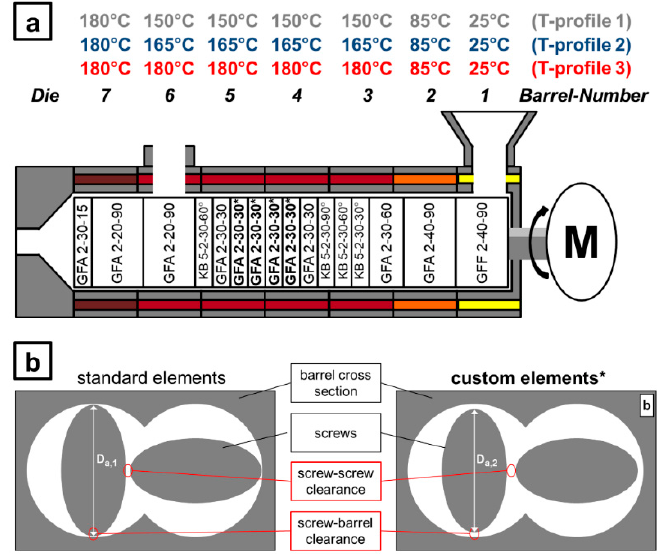
Figure 1. ( a ) Used screw configuration and varied barrel temperature profiles for the extrusion experiments. ( b ) Display of standard (left) and custom (right) screw elements within the barrel cross section. Diameter D a,1 is larger than D a,2 while the barrel diameter remains constant.